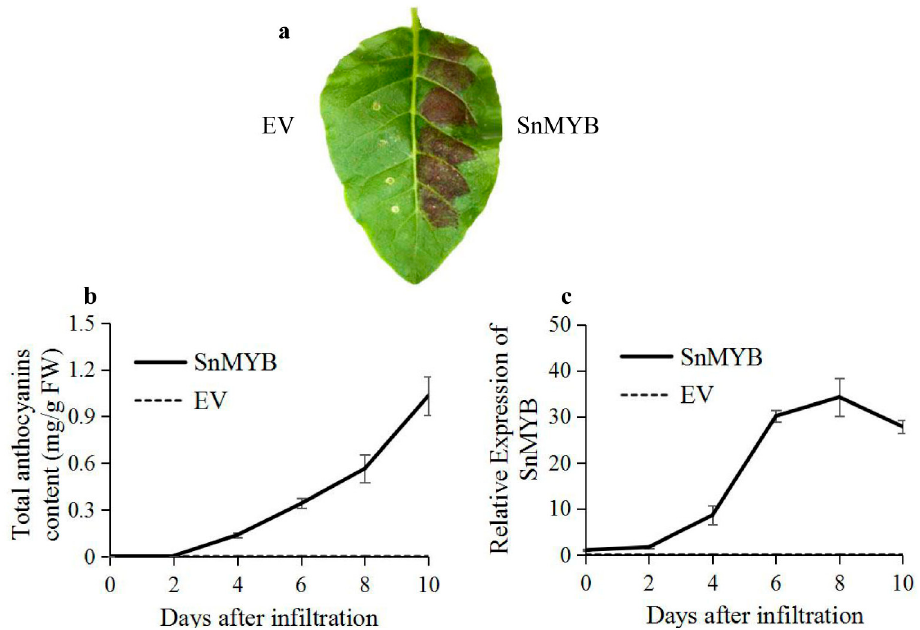
Figure 6. Transient activation of SnMYB in tobacco leaves. ( a ) Patch of anthocyanin production at the 8th day after infiltration; ( b ) Anthocyanin content; and ( c ) SnMYB expression levels in tobacco leaves infiltrated by Agrobacterium . The black solid line indicates infiltration with SnMYB , and the black dotted line indicates infiltration with the pGR106 empty vector (EV).